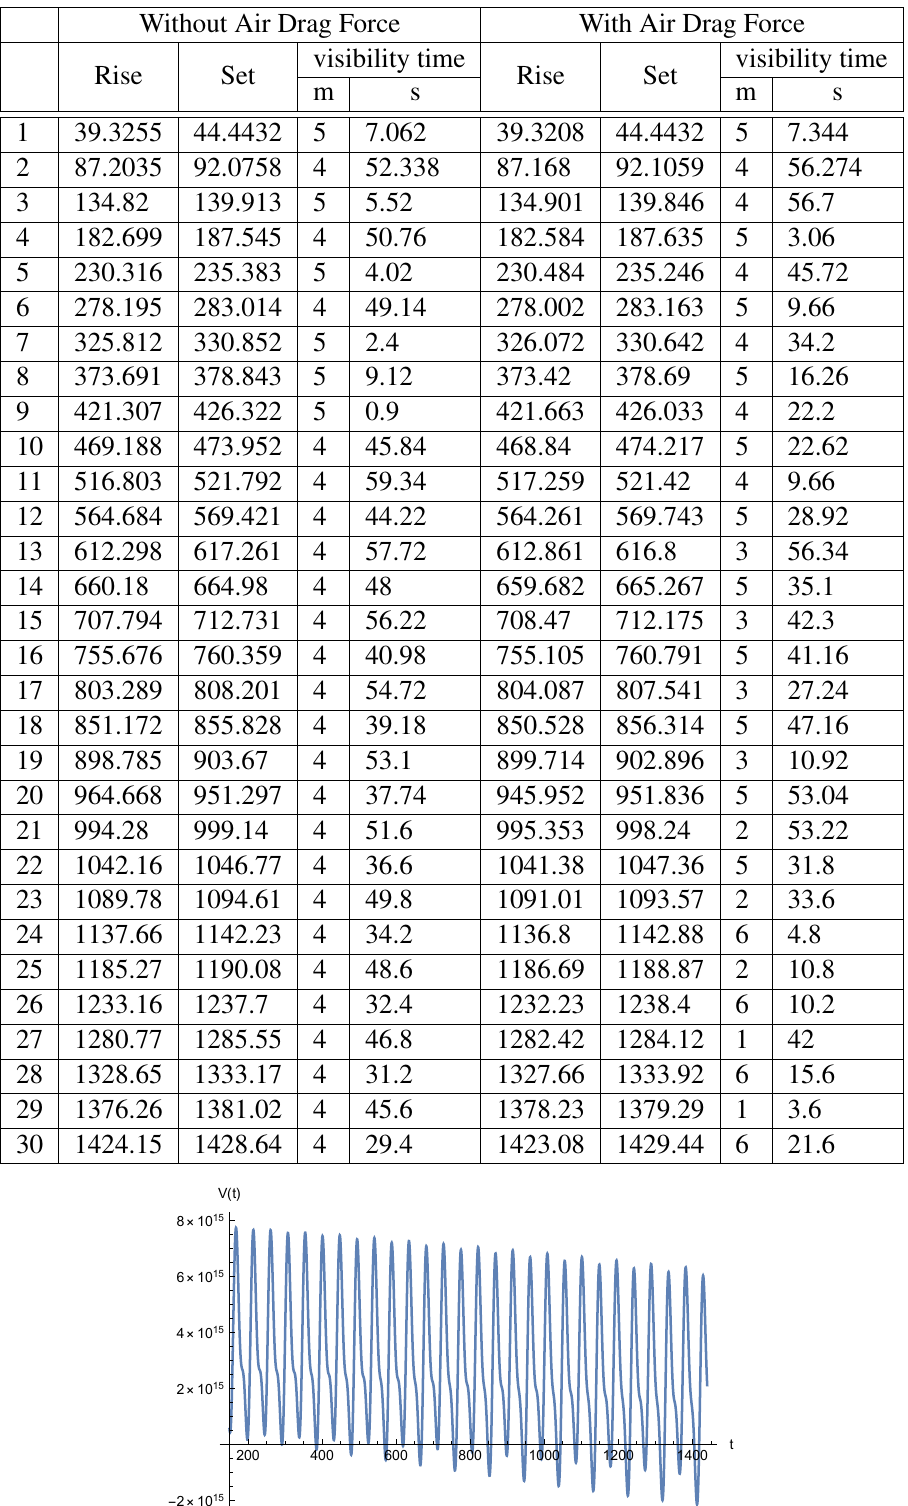
Table 4 Visibility Intervals Between HST and ODIN 24 Houres